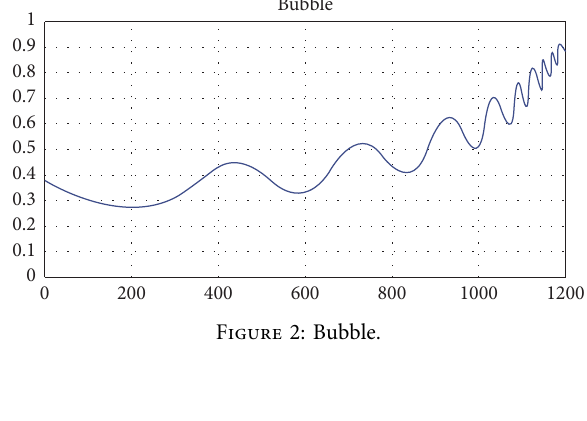
Figure 5: Reverse negative bubble.